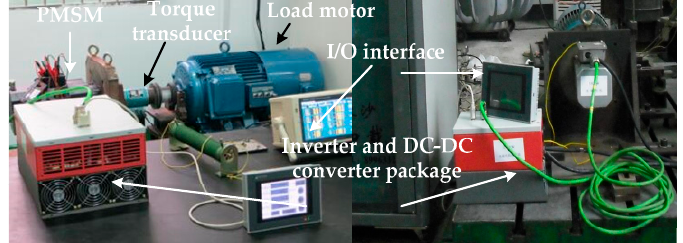
Figure 18. Laboratory prototype of current trajectory control with sampling frequency f = 5 kHz .